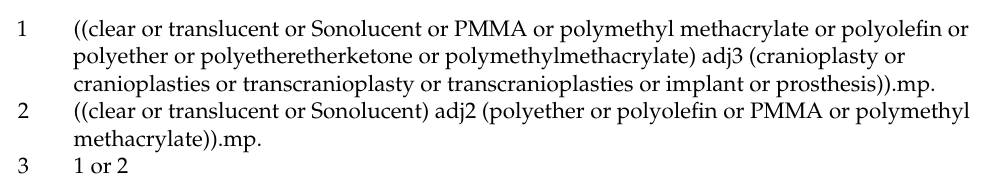
Table 1. Electronic search plan for Ovid Embase, Ovid Medline, and Web of Science Core